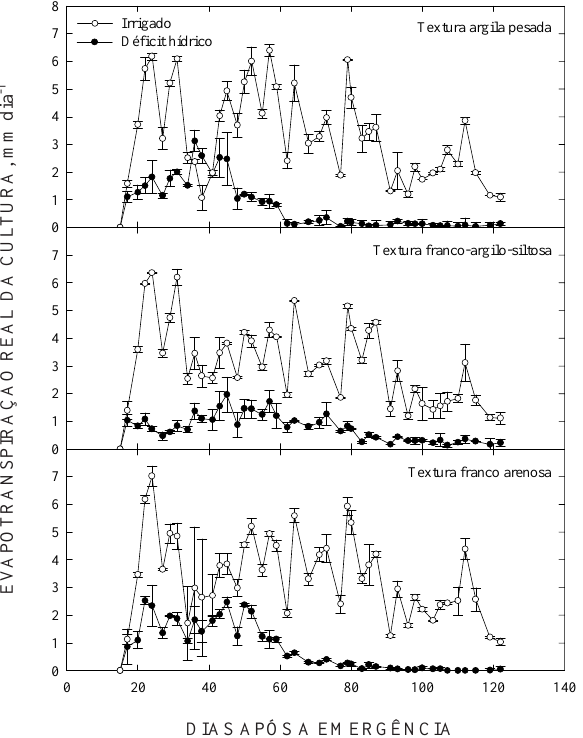
Figura 3. Evapotranspiração média da cultura do milho submetida a dois manejos da água de irrigação (irrigado e déficit hídrico terminal) em em três solos de diferentes texturas. As barras verticais representam o